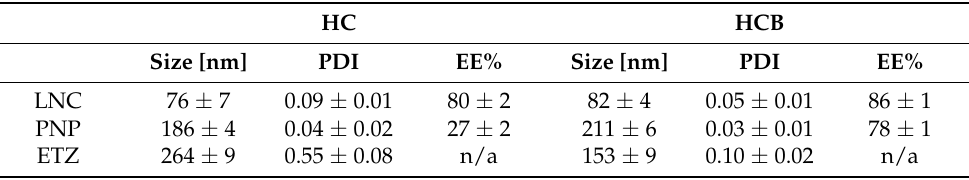
Table 4. Particle size (hydrodynamic diameter), polydispersity index (PDI), and encapsulation effi- ciency (EE) of nanosystems containing hydrocortisone (HC) or hydrocortisone-17-butyrate (HCB)